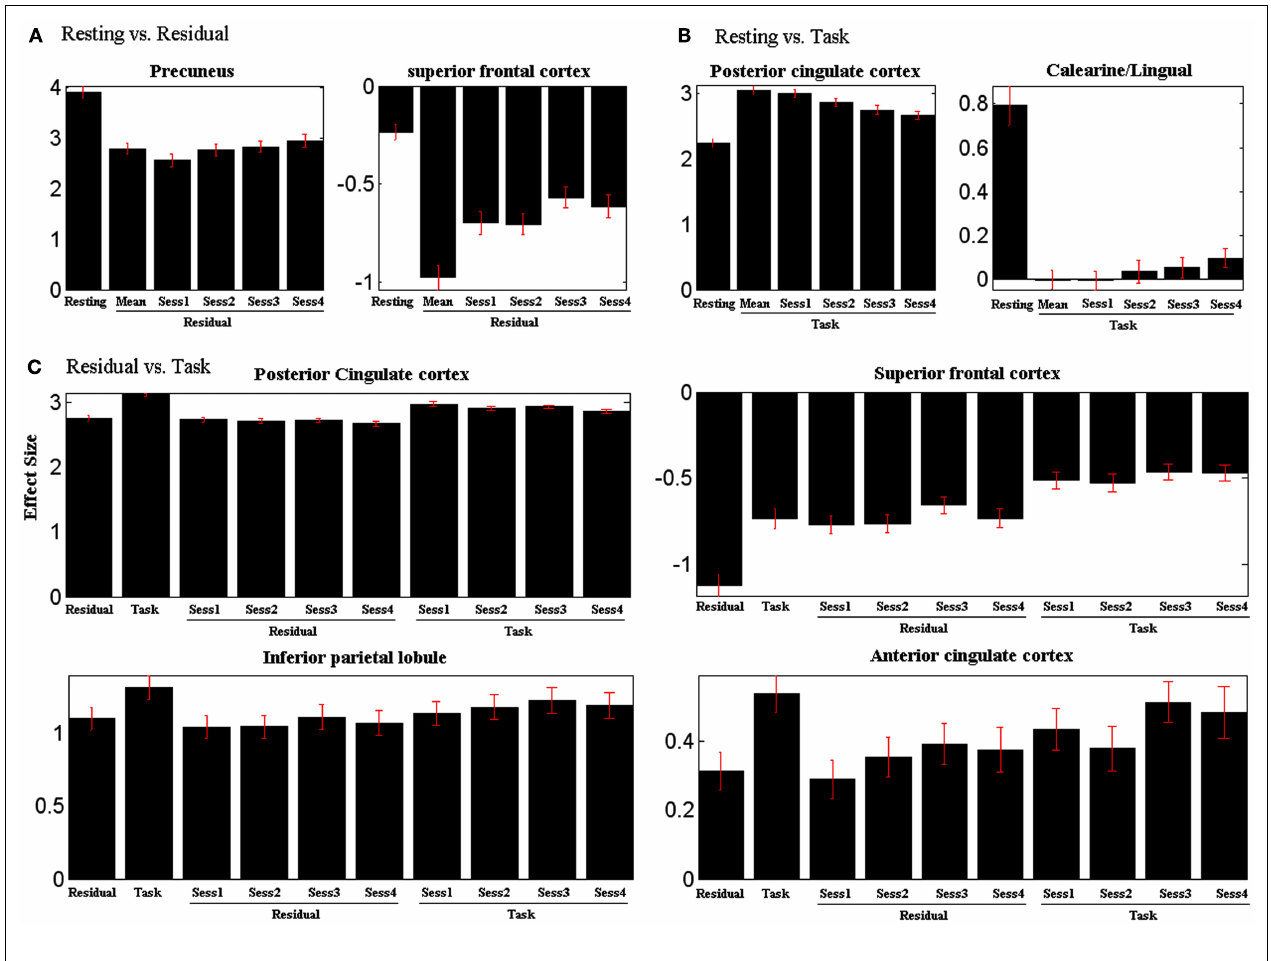
precuneus increases and task activity of the PCC decreases across sessions.Vertical bars represent standard error of the mean. See text for